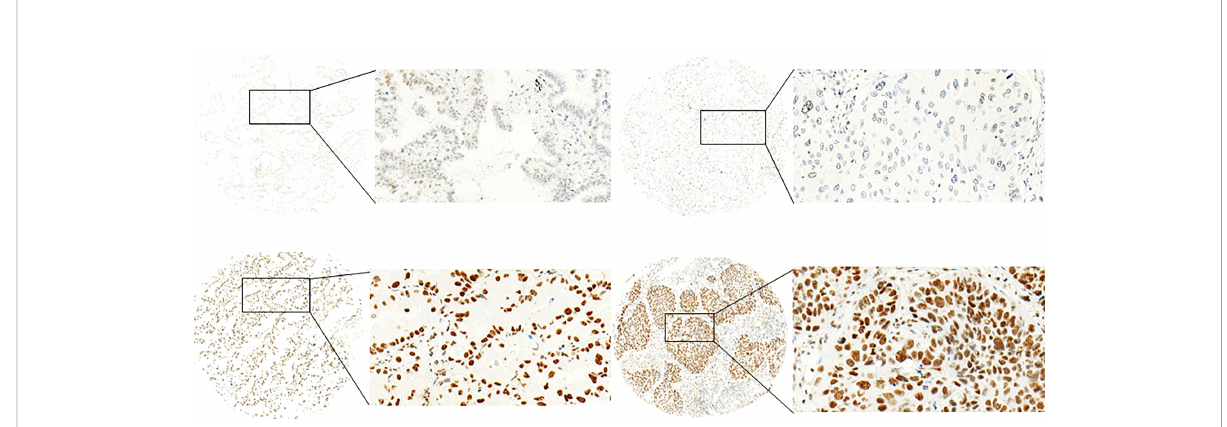
FIGURE 1 Exemplary pictures of CDK7 expression patterns in NSCLC. Left: adNSCLC with low (top) and high (below) expression (nuclear DAB OD 0.1547 and 0.5006, respectively). Right: sqNSCLC with low (top) and high (below) expression (nuclear DAB OD 0.1524 and 0.3969, respectively) of